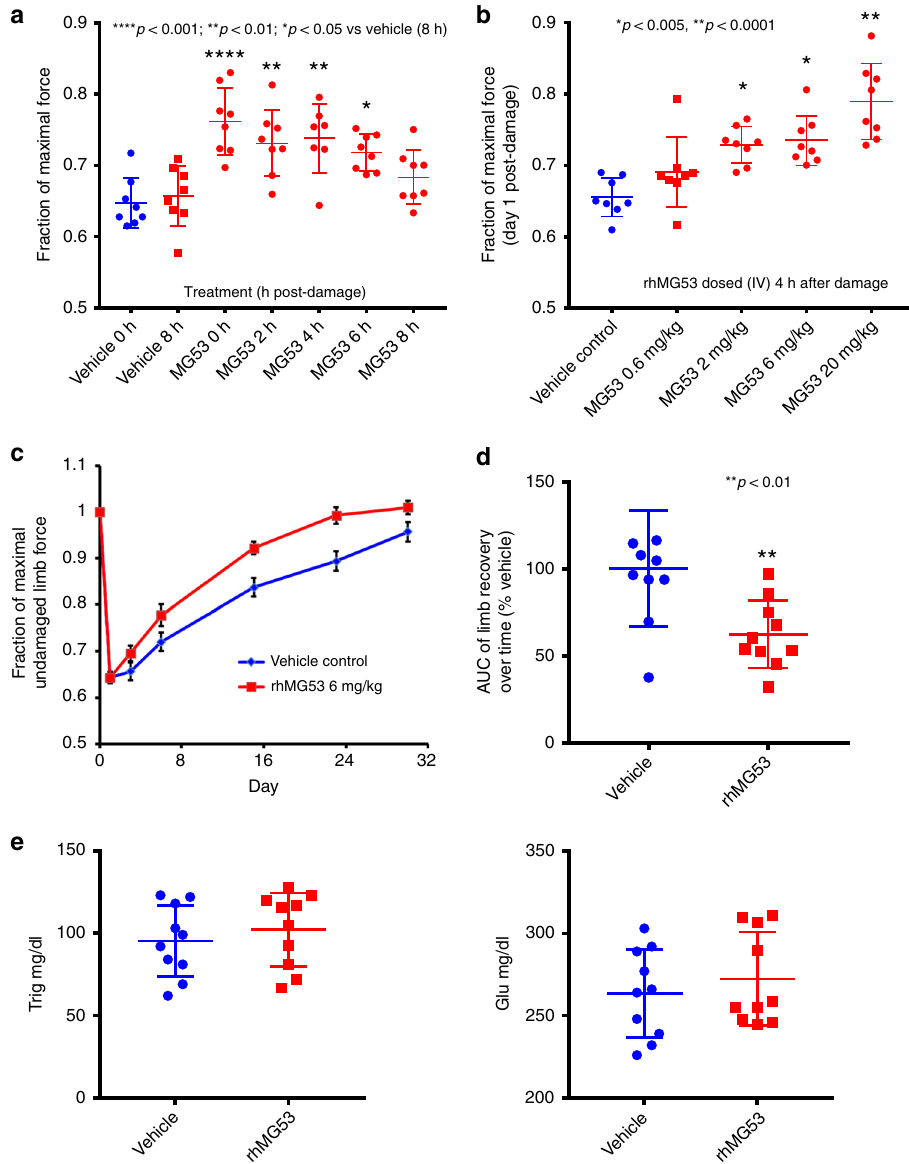
Fig. 7 rhMG53 protects against eccentric-contraction-induced acute and chronic muscle injury in mice. a Time-dependent effects of rhMG53 in protection against eccentric-contraction-induced acute muscle injury in mice. rhMG53 (2 mg/kg, i.v.) was administered at different times after muscle injury. b Dose- dependent effect of rhMG53 in protection against eccentric-contraction-induced acute muscle injury in mice. Various doses of rhMG53 were administered at 4 h post muscle injury. c 24 h after eccentric-contraction-induced muscle injury, rhMG53 (6 mg/kg) was administered subcutaneously. Mice were treated on a daily basis for 28 days. d Area under the curve (AUC) shows signi fi cant bene fi cial effects of rhMG53 in facilitation of recovery of contractile function after eccentric-contraction-induced muscle injury ( p < 0.001, compared with saline control). e Blood glucose and triglyceride measurement did not show signi fi cant changes after 28 doses of 6 mg/kg (s.c., daily) in mice. Error bar represents the standard deviation and p value was generated by t